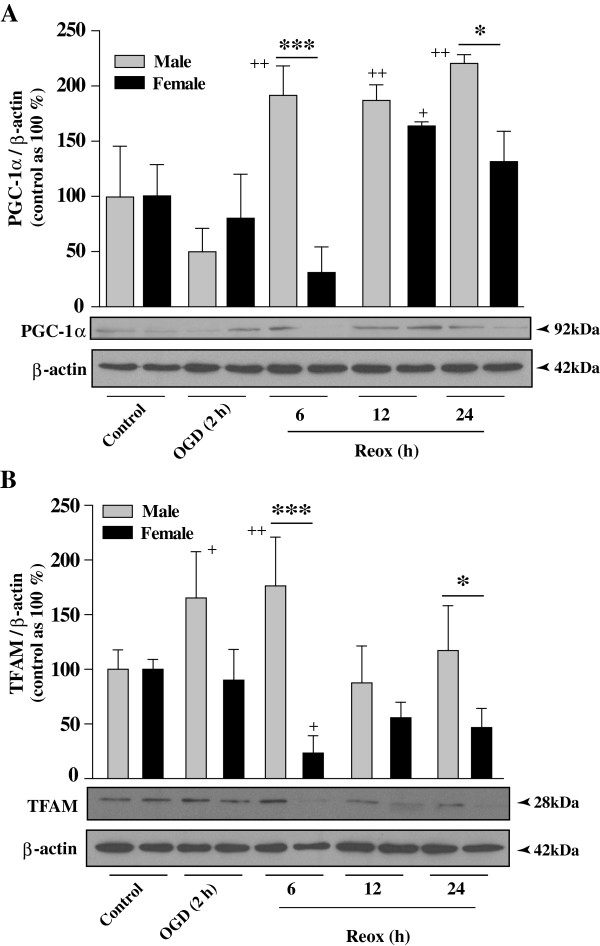
Protein expression of mitochondrial biogenesis factors in XY and XX CGNs upon exposure to OGD (2 h) and reoxygenation (6–24 h). Western blot analyses of PGC-1α (A) and TFAM (B) were performed using total cellular extracts of XY and XX CGNs from either normoxia control or exposed to OGD/Reox for the indicated time points. Histograms show values for TFAM and PGC-1α normalized to actin. Values are expressed as mean ± SD from four independent experiments (*p < 0.05, ***p < 0.001 XX vs. XY, +p < 0.05, ++ p < 0.01 vs. control, a one-way ANOVA followed by Bonferroni/Dunn post hoc test was applied). Quantification of TFAM and PGC-1α specific bands showed increased expression in XY compared to XX CGNs.